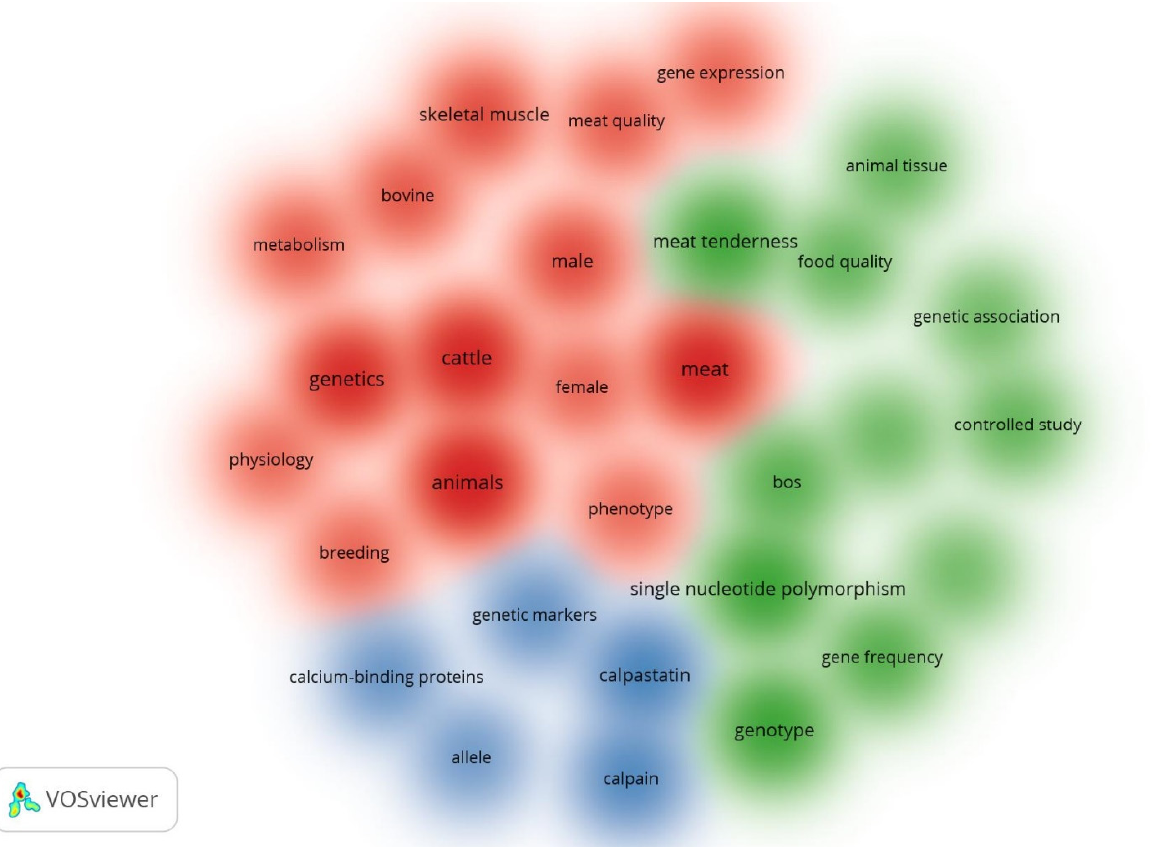
Figure 5. Cluster density visualization map of keywords with at least 25 occurrences.